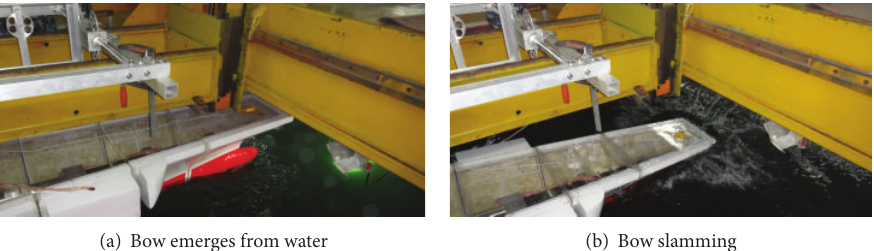
Figure 10: Bow impact with the wave (scheme 1).